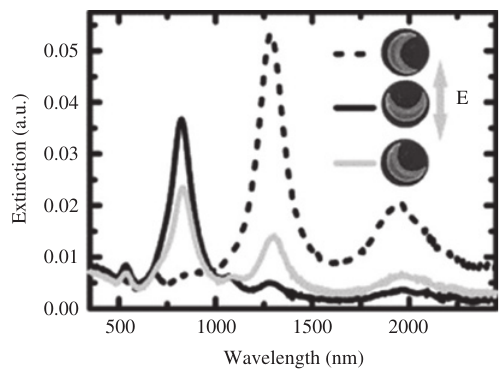
Figure 17: UV-vis near-IR polarized extinction spectra for gold crescents fabricated on glass